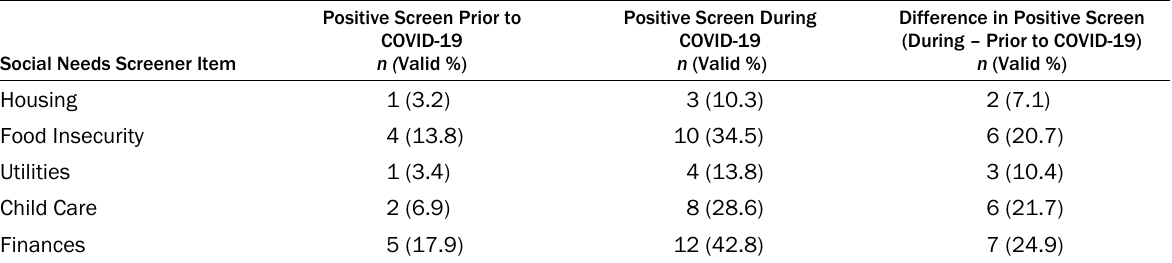
Table 4. Comparison of Positive Social Needs Screener Results Prior to and During COVID-19 Among a Sample of Tennessee Farmers